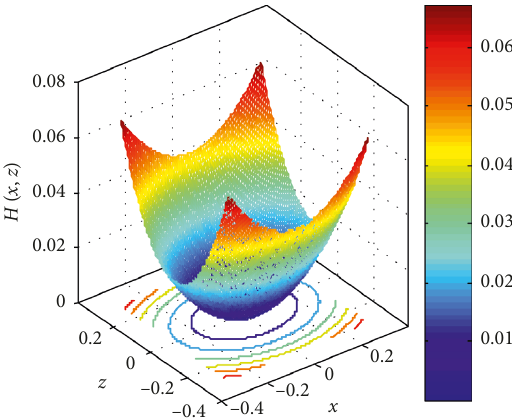
Figure 13: Hamilton function of the unperturbed system.